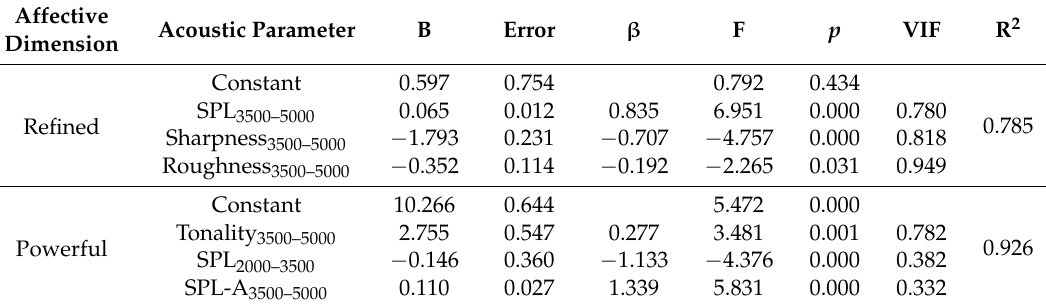
Table 9. Results of regression analysis of affective dimensions for acoustic parameters from 2000 to 3500 and 3500 to 5000 RPM.